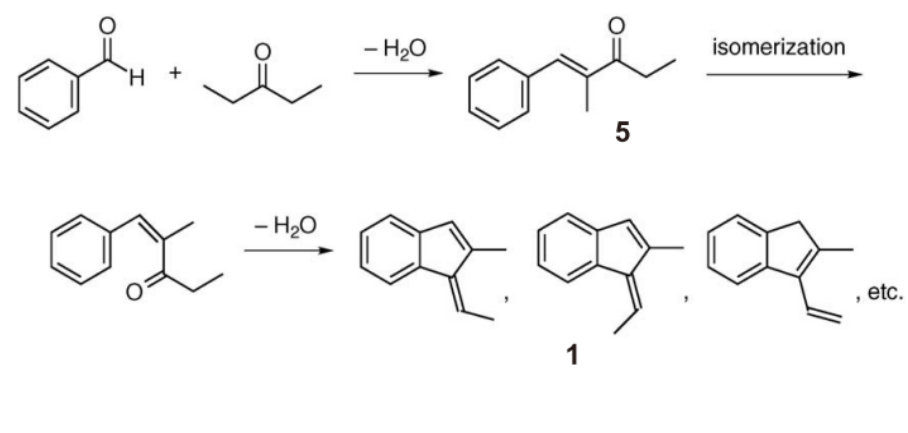
a After activation of cluster (100 mg, 2.9 μmol) in a helium stream (300 mL/h) at 400 °C for 1 h, reaction was started by introduction of ketone (0.57 mmol/h) and benzaldehyde (58 ìL/h, 0.57 mmol/h) to the stream without changing the temperature. At 3 h after the start of the reaction. Other conditions are the same as in Figure 23.; b 1-Methyleneindene (2.2%) and 3-methylindene (4.2%); c 2-Methyl-1-methyleneindene (4.5%) and 2,3-dimethylindene (18.9%); d 2-Ethyl-1-methyleneindene (13.6%) and 2-ethyl-3-methylindene (17.8%).; e Z -1-Ethylidene-2-methylindene (45.9%), E -1-ethylidene-2-methylindene (14.7%), 2-methyl-3-vinylindene (6.1%), and 3-ethyl-2-methylindene (11.7%).; f Butyl ether solution (15%) in the absence of benzaldehyde; g 1-Methyleneindene (3.5%) and 3-methylindene (32.3%).; h 4-Phenyl-2-butanone, 1-phenyl-1-butene, naphthalene, etc. Scheme 2. Formation of indenes from benzaldehyde and